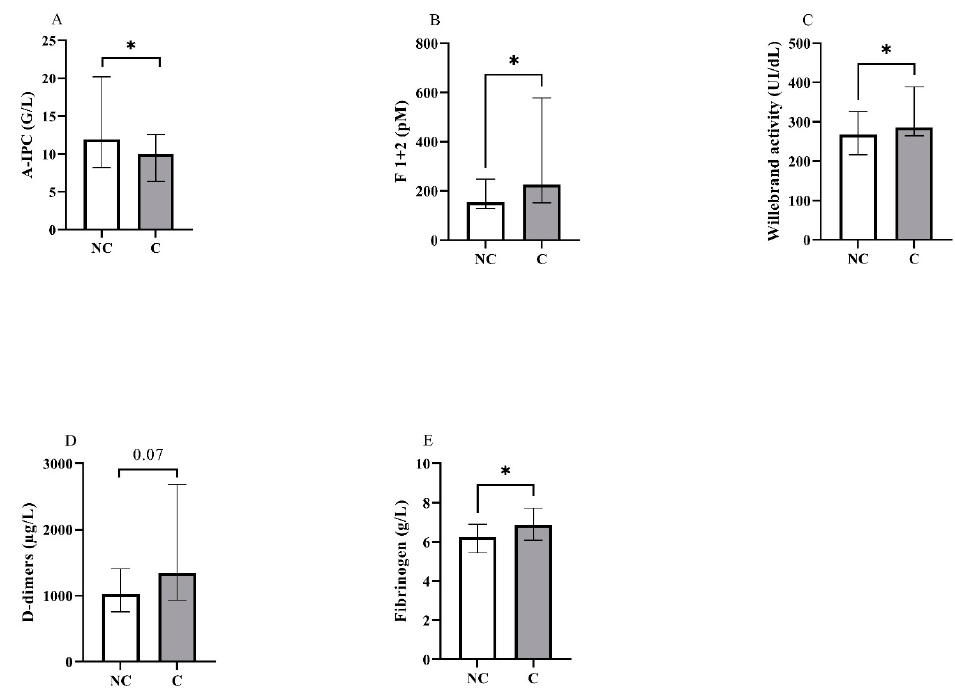
Figure 1. Representation in non-critical (NC) and critical (C) groups of the blood levels for ( A ) absolute immature platelet count (A-IPC), ( B ) prothrombin fragments 1 + 2, ( C ) von Willebrand activity, ( D ) D-dimers and ( E ) fibrinogen. *: p < 0.05. Concerning blood counts, we observed a significant difference between groups for A-IPC, lymphocytes, NLR and NPR. Concerning hemostasis biomarkers, fibrinogen levels, vWF:GPIb-binding activity and F1 + 2 were also increased in the critical group. Thrombin generation assays showed no difference between groups (Figure 2 and see Supplementary Material Figure S1 for the descriptive curves of thrombin generation).